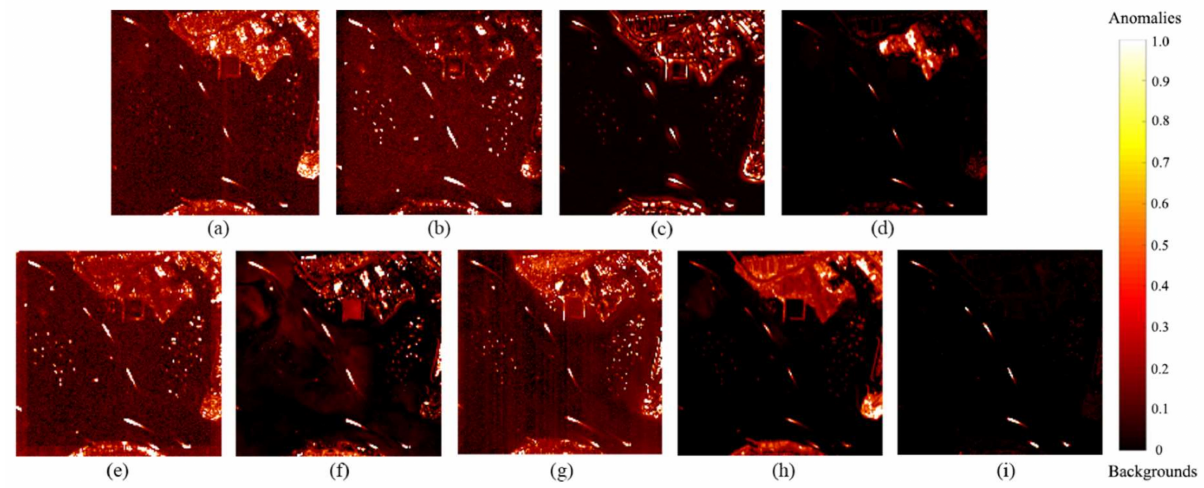
Figure 7. Detection results of the various algorithms for the Belcher Bay Image: ( a ) RX, ( b ) LRX, ( c ) KRX, ( d ) SSRX, ( e ) CRD, ( f ) LSMAD, ( g ) GTVLRR, ( h ) PRLRaSAD, and ( i )